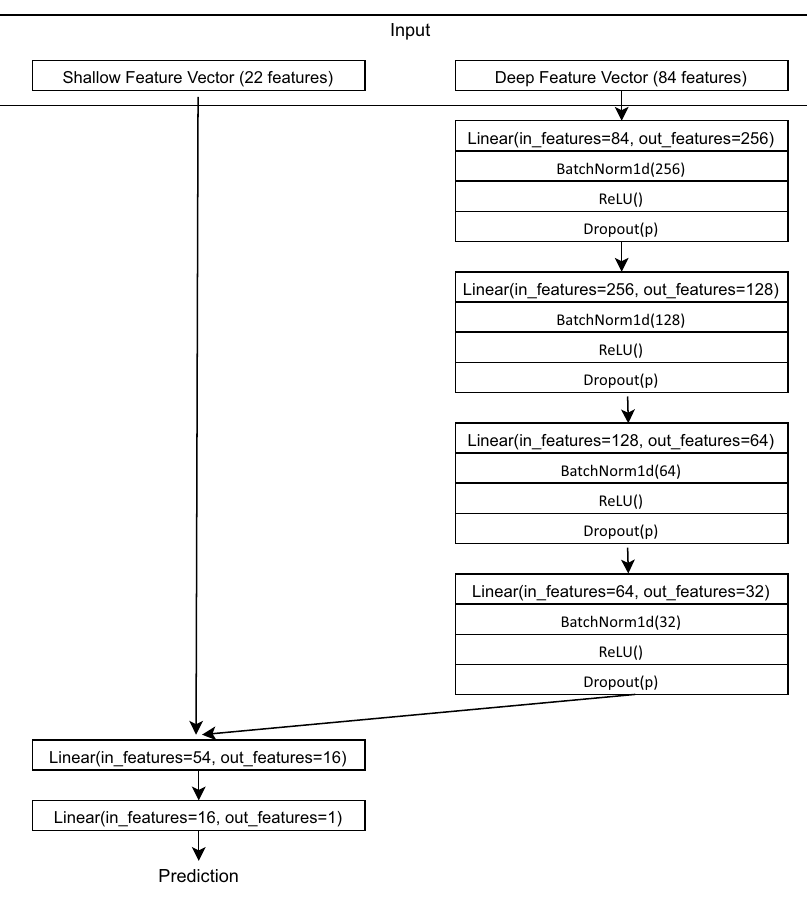
Figure 4. Fusion Network